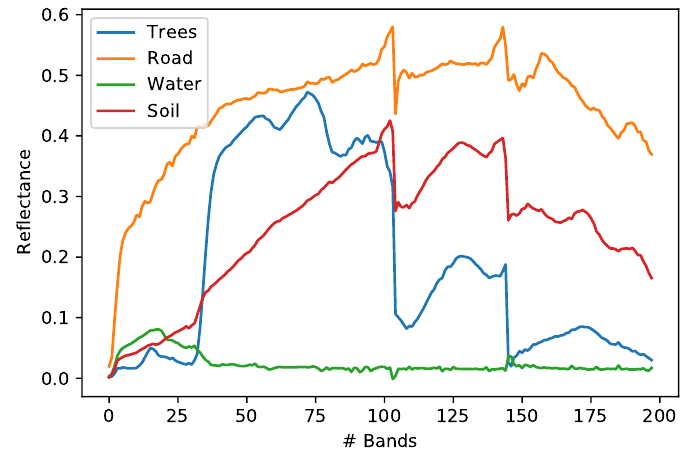
Figure 6. Endmembers extracted by the proposed method for the Jasper Ridge.